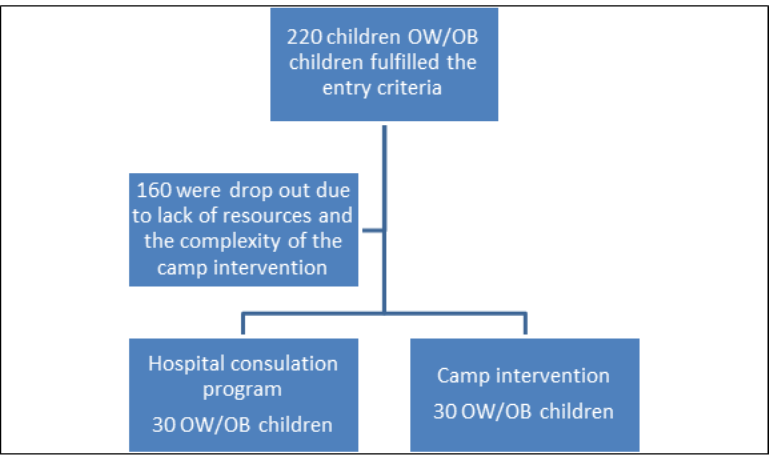
Figure 1. Flowchart of children recruitment for both intervention programs. OB; obese, OW; over-weight.